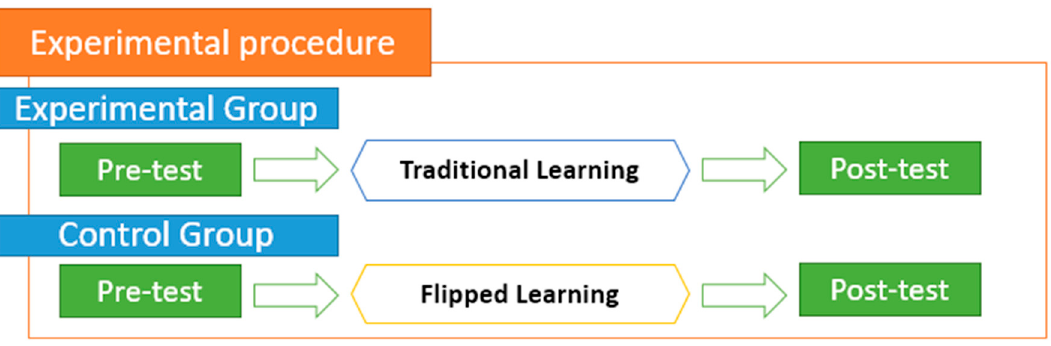
Figure 1. Overview of experiment procedure.